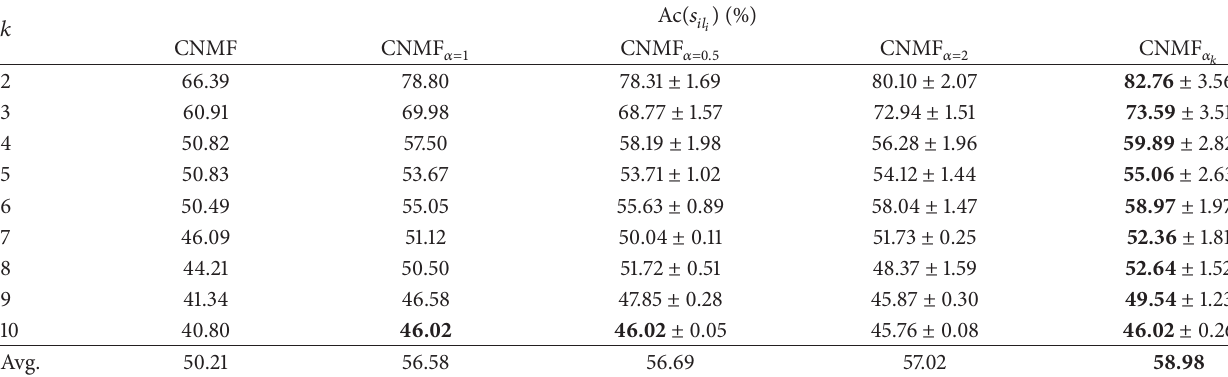
Table 5: The comparison of classification accuracy rates on the Caltech 101 Database.